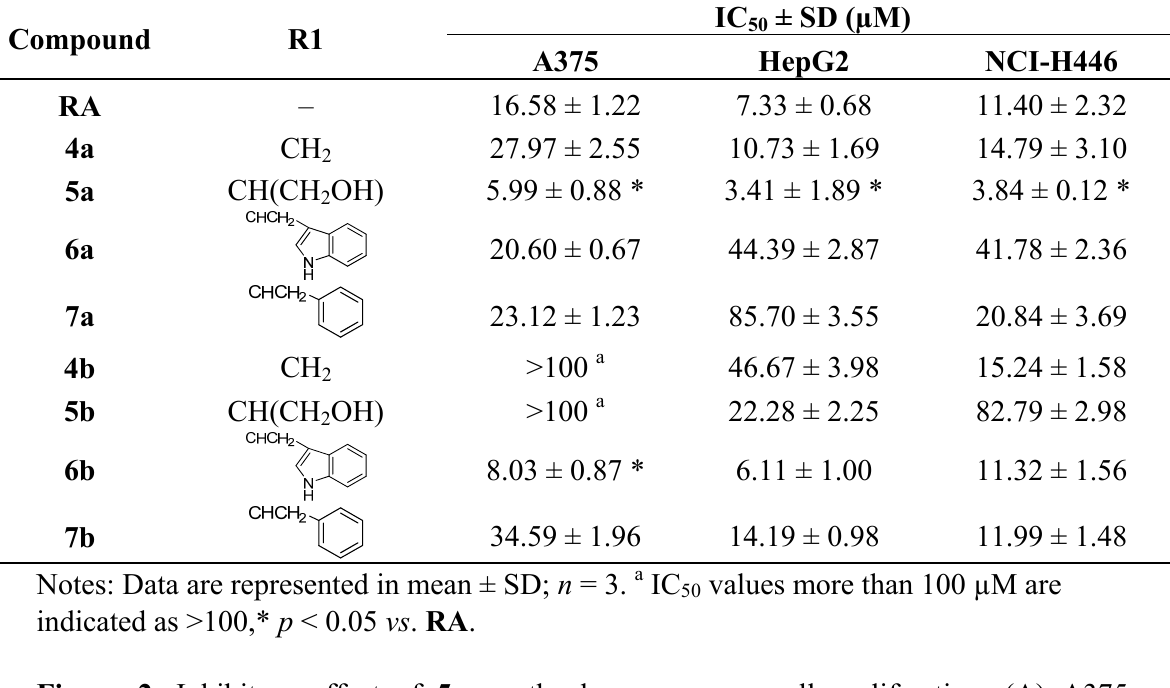
Table 1. The IC values of RA and its derivatives 4a–7a , 4b–7b on human cancer cell lines ( μ M). 50 Compound